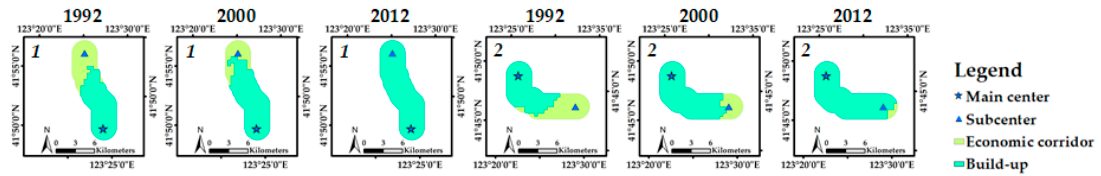
Figure 10. Results of the built-up areas within the economic corridor for Shenyang.